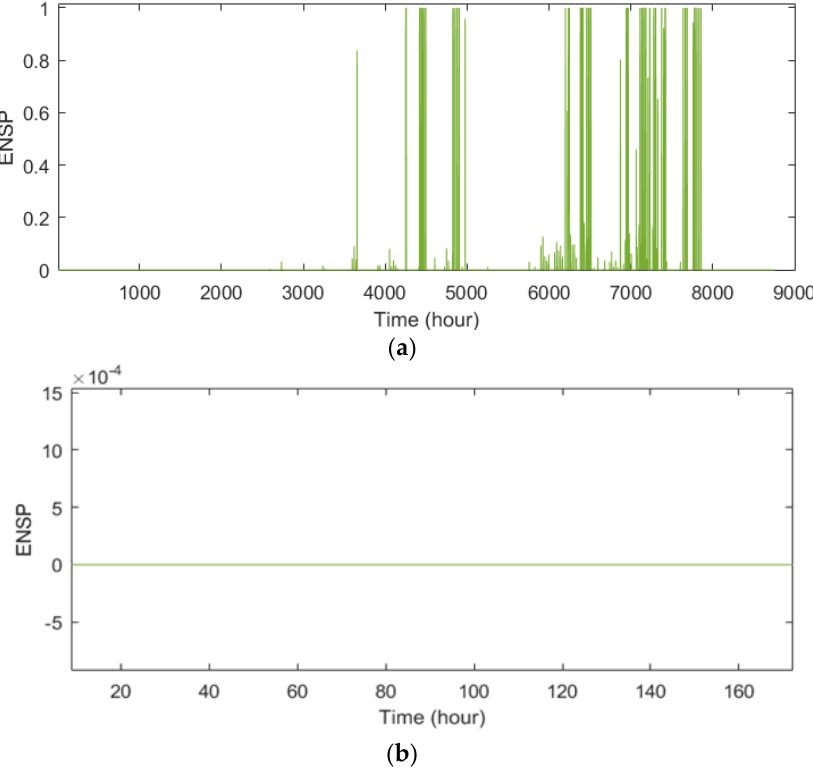
Figure 17. ENSP in the sizing of the HPV/FC energy system via the IAEO, considering ENSP max = 5% during ( a ) a year and ( b ) a week.